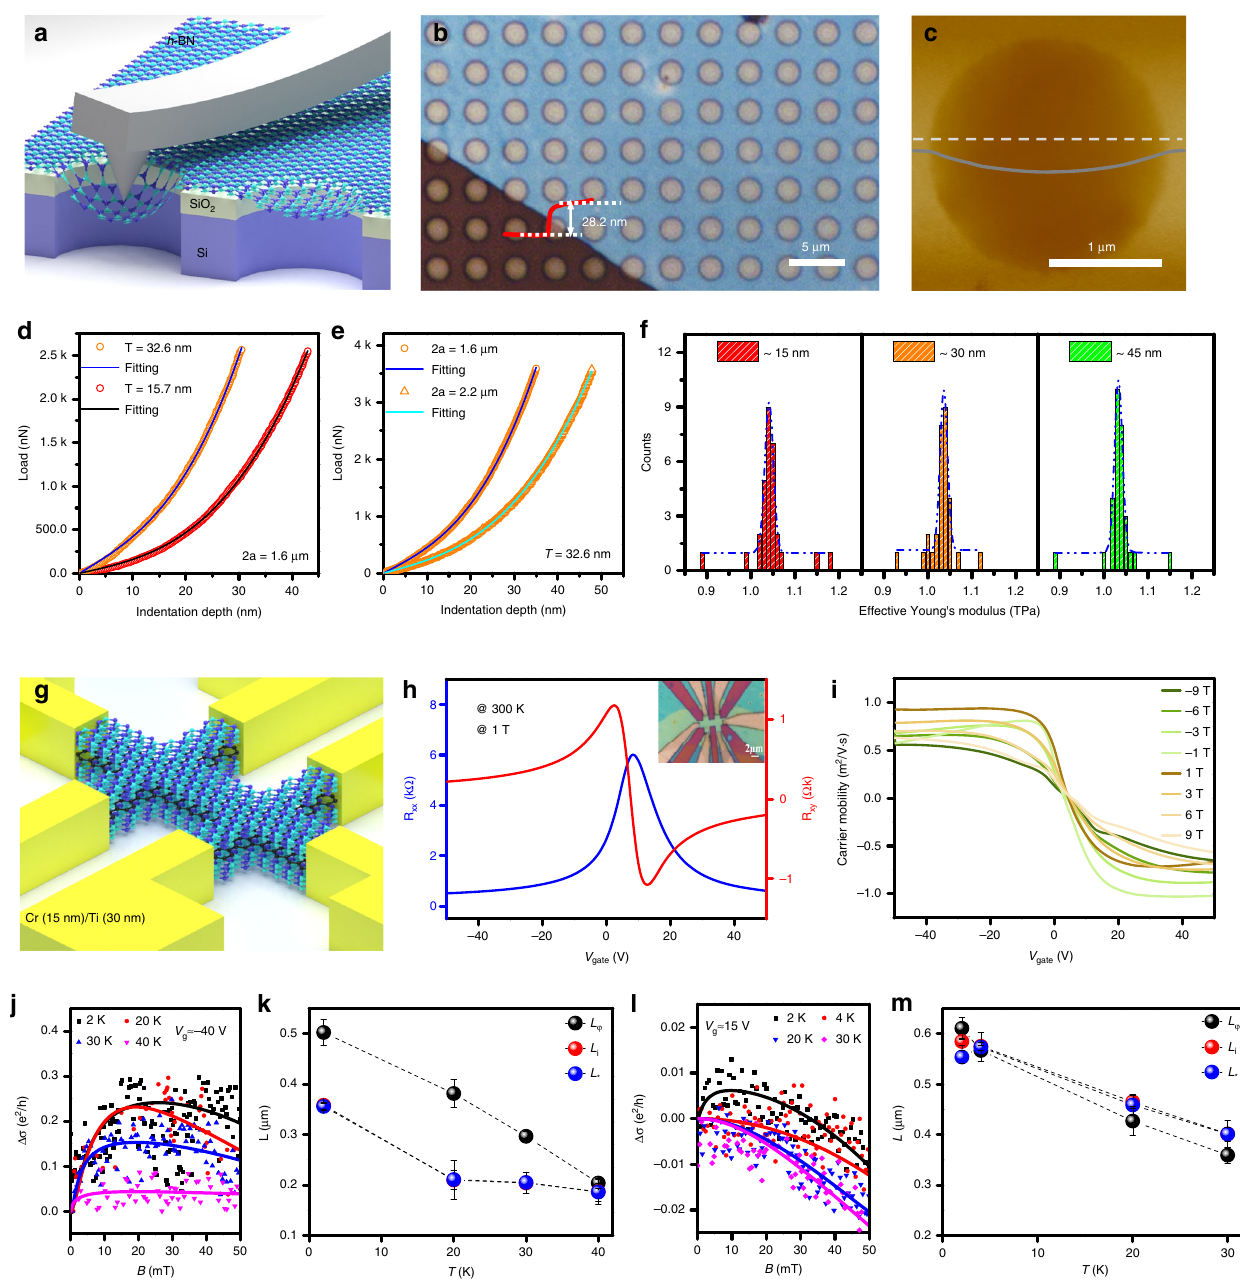
Fig. 5 Mechanical strength of multilayer h -BN fi lm and electron transport of the h -BN/graphene/ h -BN device. a Schematic of nanoindentation on suspended multilayer h -BN fi lm. b OM image of h -BN membranes lying on SiO 2 (300 nm)/Si substrate with patterned circular wells. c AFM image of one membrane, 2.2 μ m in diameter. The solid line is a height pro fi le along the dashed line. d Measured force-displacement curves of multilayer h -BN with different thicknesses. e Measured force-displacement curves of multilayer h -BN with different fi lm diameters. f Histogram of Young ’ s modulus with different thicknesses. Dashed lines represent Gaussian fi ts to data. g Schematic diagram of the h -BN/graphene/ h -BN Hall bar con fi guration. h The relationship of R xx and R xy versus gate voltage ( V g ) at 300 K under 1 T. An OM image of the h -BN/graphene/ h -BN Hall bar device is shown in the inset. i Magnetic fi eld dependence of the carrier mobility versus V g . j Normalized magneto-conductivity (MC) measured at different temperatures with V g at approximately − 40 V; those solid lines are fi tting curves. k Temperature dependence of three characteristic lengths (L φ , L i, L ∗ ) extracted from ( j ). l Normalized MC measured at low temperatures with V g maintained at 15 V. m Temperature dependence of L φ , L i and L ∗ extracted from ( l ). Error bars in ( k ) and ( m ) for the experimental data represent standard deviation of uncertainty in characteristic lengths (L φ , L i, L ∗ )